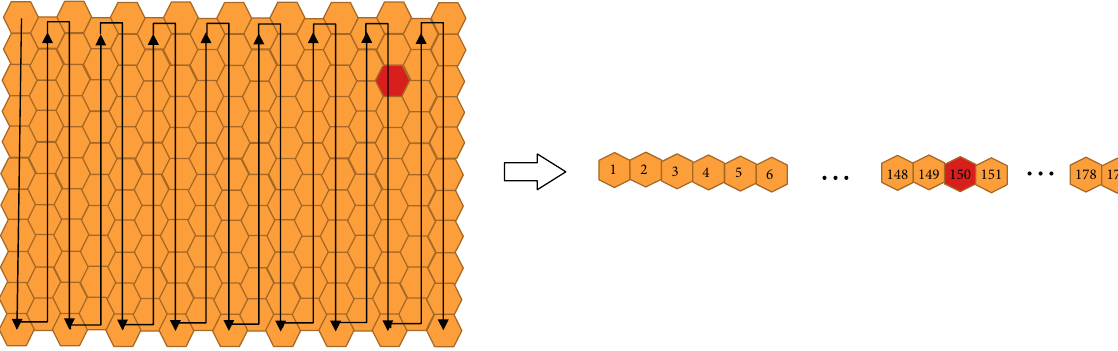
Figure 10: Schematic diagram of the one-dimensional coding of a hexagonal